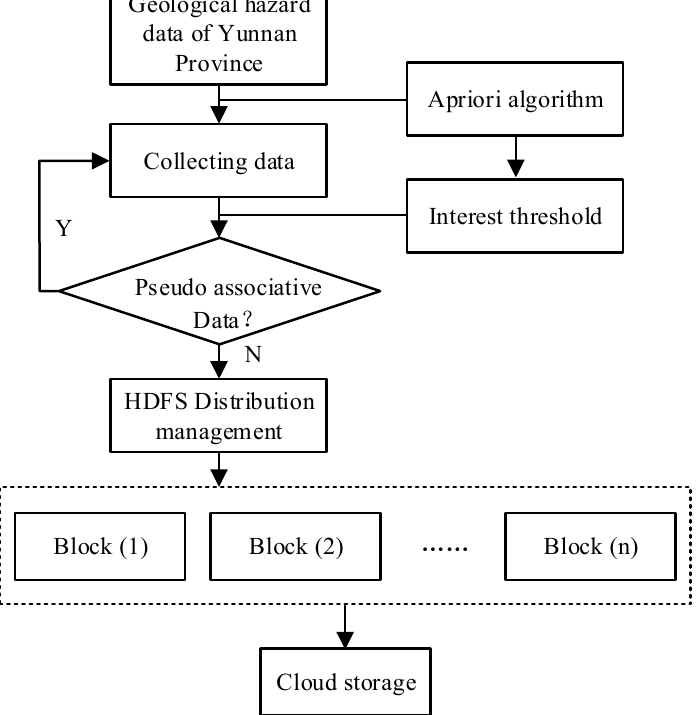
Figure 1. Geological hazard collection and treatment